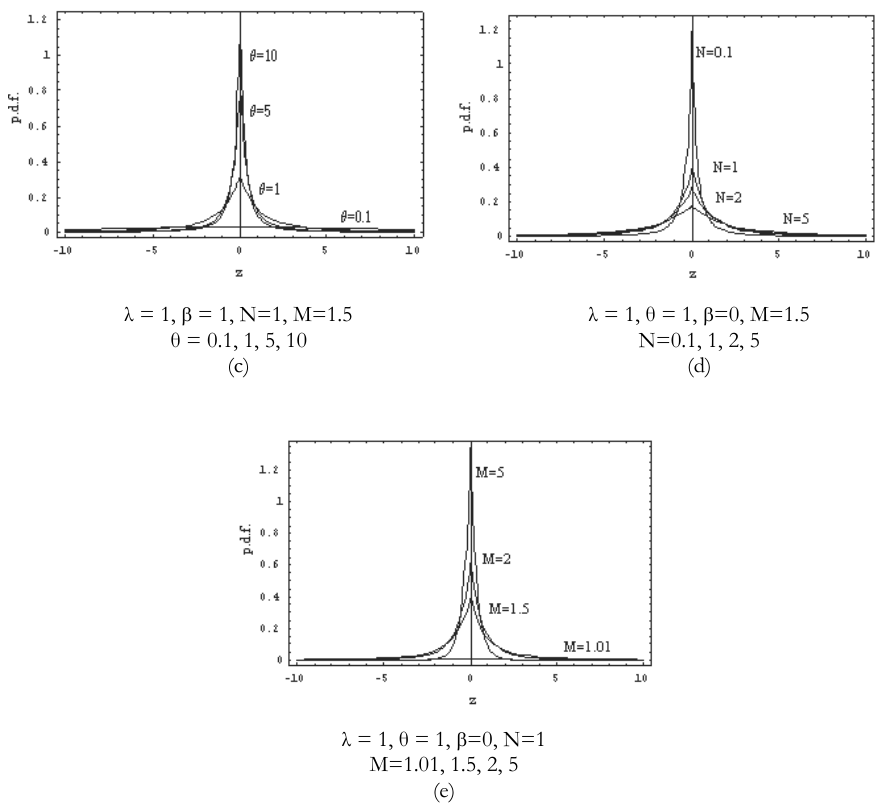
Fig. 2 – Different possible shapes of the p.d.f. (39) for specified values of parameters λ ,  , θ , N and M